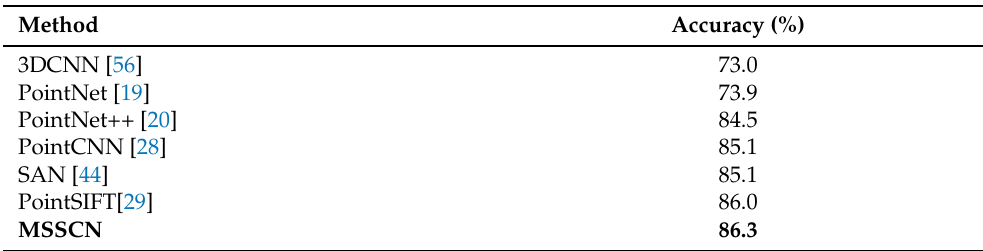
Table 3. Comparison of the accuracy of different methods on ScanNet [56].